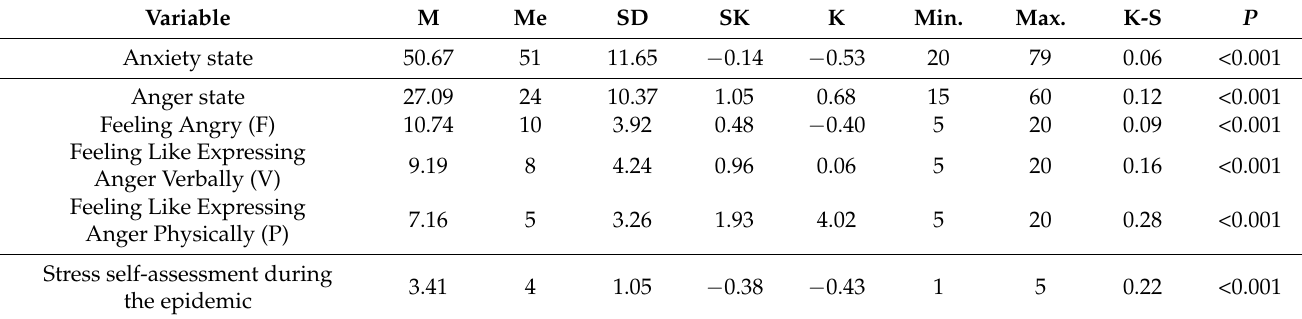
Table 2. Descriptive statistics of quantitative variables in stage I (n =